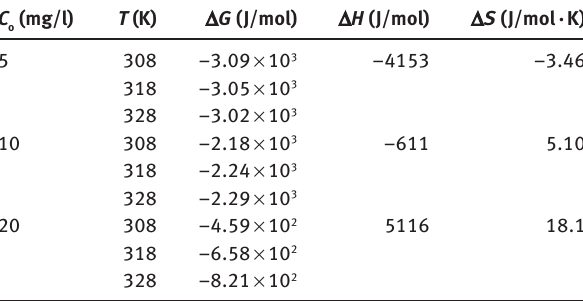
Table 4: Thermodynamics properties of methylene blue adsorption by basic-treated human hair